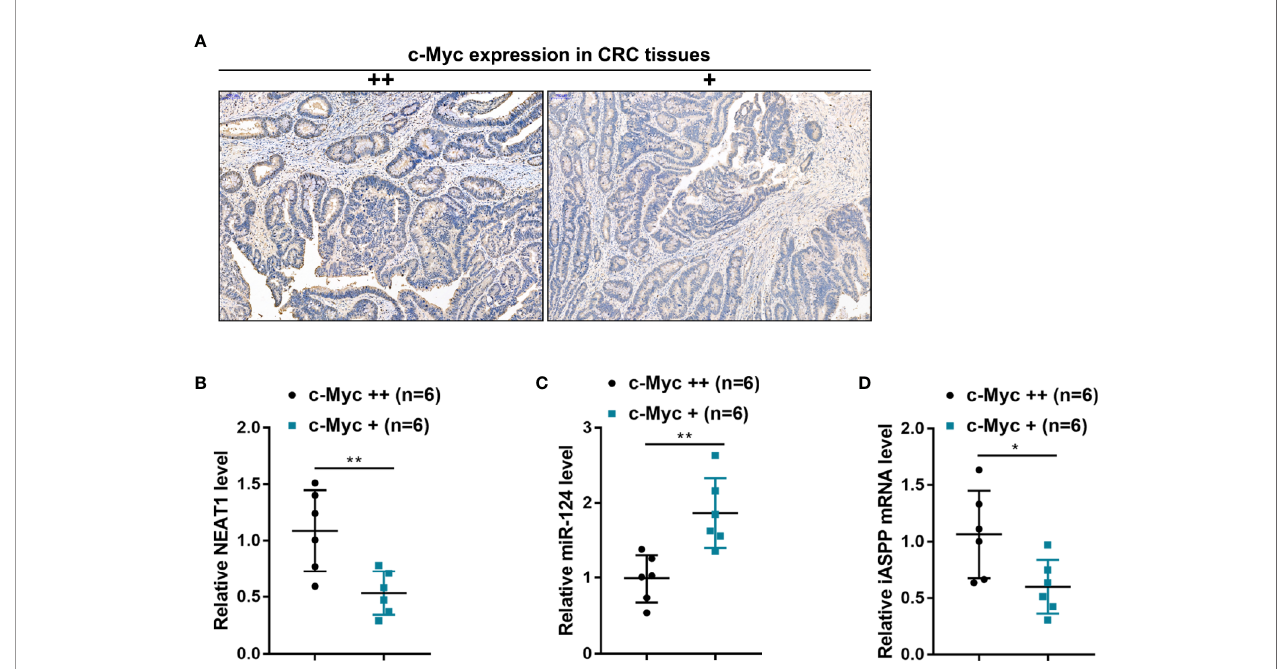
FIGURE 8 | The expression of the NEAT1/miR-124/iASPP axis in human CRC tissues (A) By using an antibody speci fi c to c-Myc, the c-Myc protein in CRC tissue samples was identi fi ed by IHC staining. c-Myc abundance was evaluated, and CRC tissues were divided into c-Myc+ and c-Myc++ groups accordingly. (B – D) The expression levels of NEAT1, miR-124, and iASPP were determined in c-Myc+ and c-Myc++ CRC tissues by qRT-PCR. * P < 0.05, ** P < 0.01 compared with c-Myc+